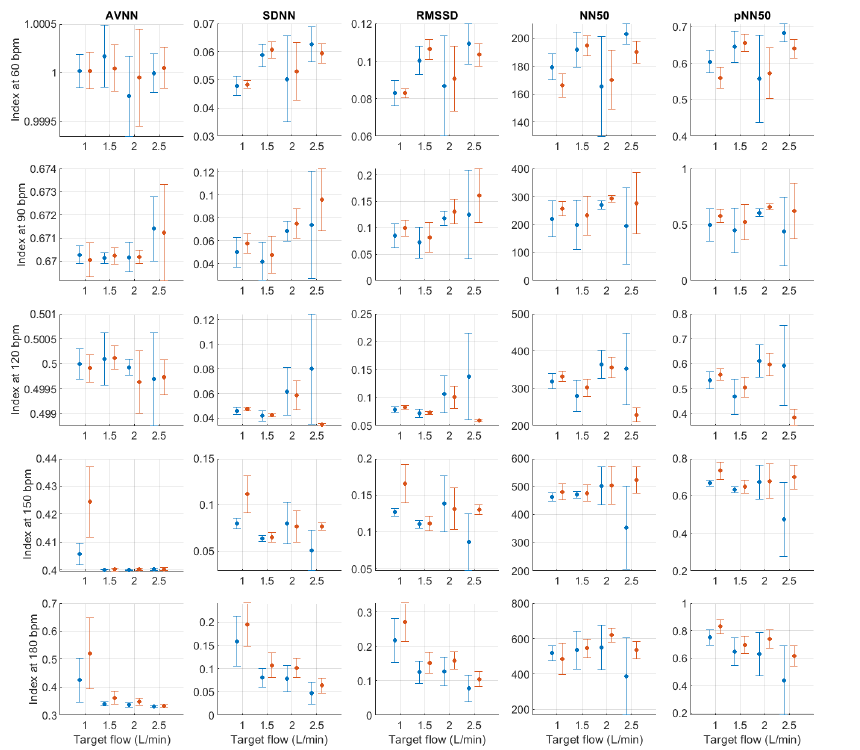
Figure A4. Mean and standard deviation of time-domain indices extracted from pulse rate variability under different stroke rates (SR) and target flows (TF, TF below 2.5 L/min) conditions, and measured from the radial (blue) and deep palmar arch (orange)